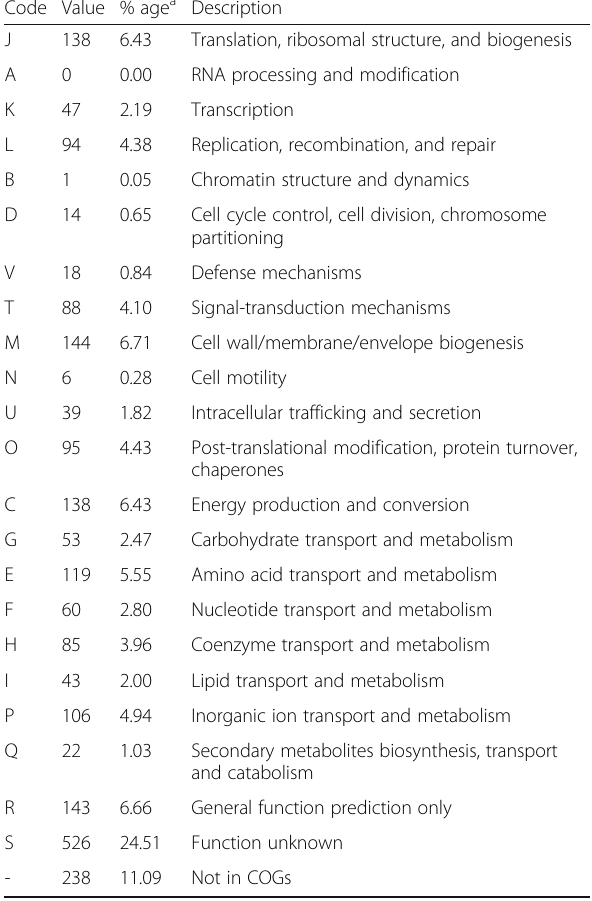
Table 4 Number of genes associated with the general COG